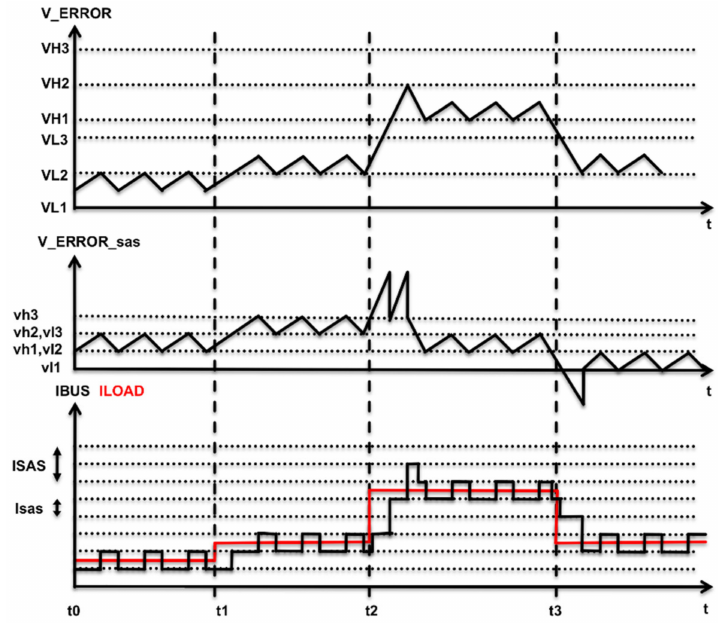
Figure 5. Typical regulator